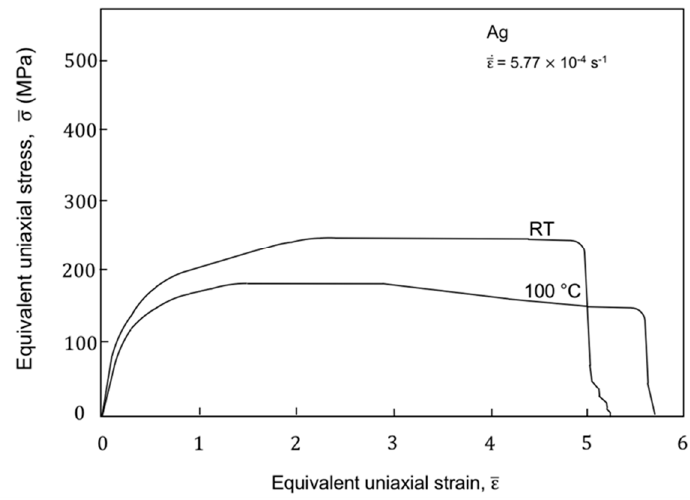
Figure 4. The large strain torsional deformation of pure silver at low temperatures [19].